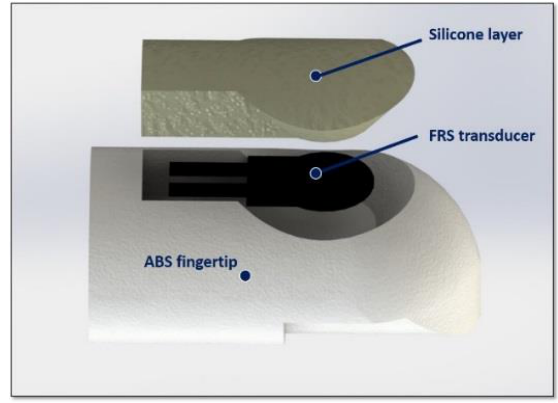
Figure 3. The sandwich layers configuration around the tactile